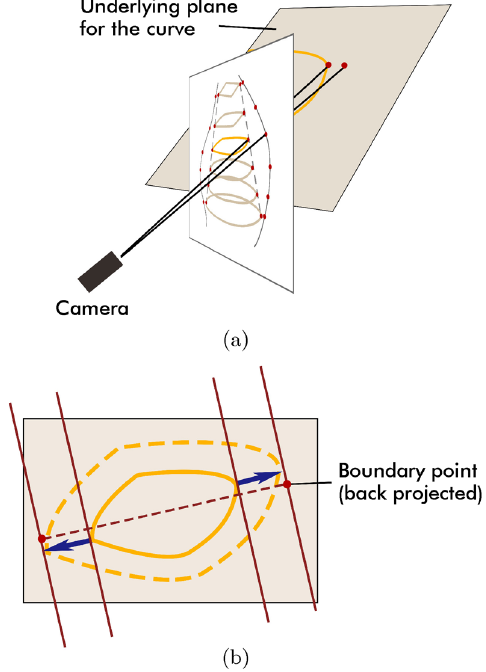
Fig. 5 Transforming a section curve in 3D to fit the shape silhouette in 2D. (a) The positions of the boundary points in 3D are uniquely determined by intersecting the camera ray with the underlying plane of the curve (light brown). (b) A shape-preserving scaling of the curve on its underlying plane is guided by the back projected boundary points. The four red solid lines are orthogonal to the red dotted